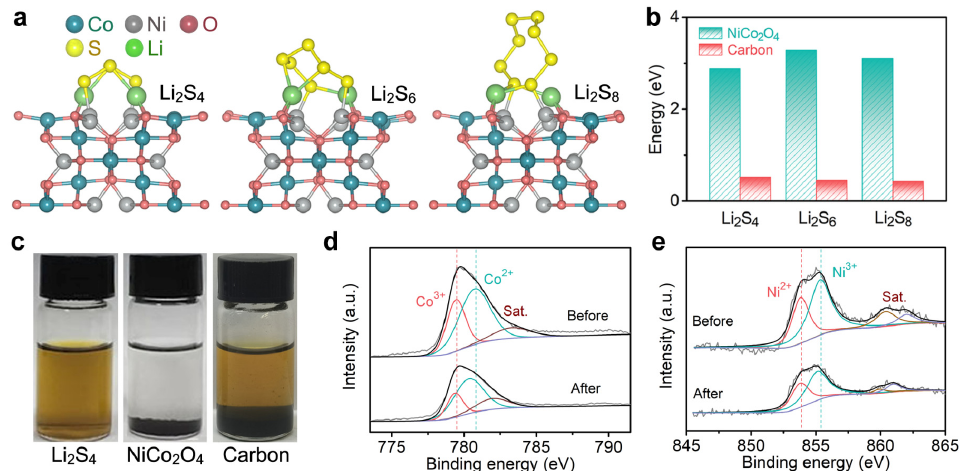
Figure 3. ( a ) Mechanism diagram of interaction between NiCo 2 O 4 and LiPSs. ( b ) The corresponding adsorption energies. ( c ) Visual adsorption of Li 2 S 4 . ( d ) Co 2p and ( e ) Ni 2p XPS results of NiCo 2 O 4 before and after Li 2 S 4 adsorption.